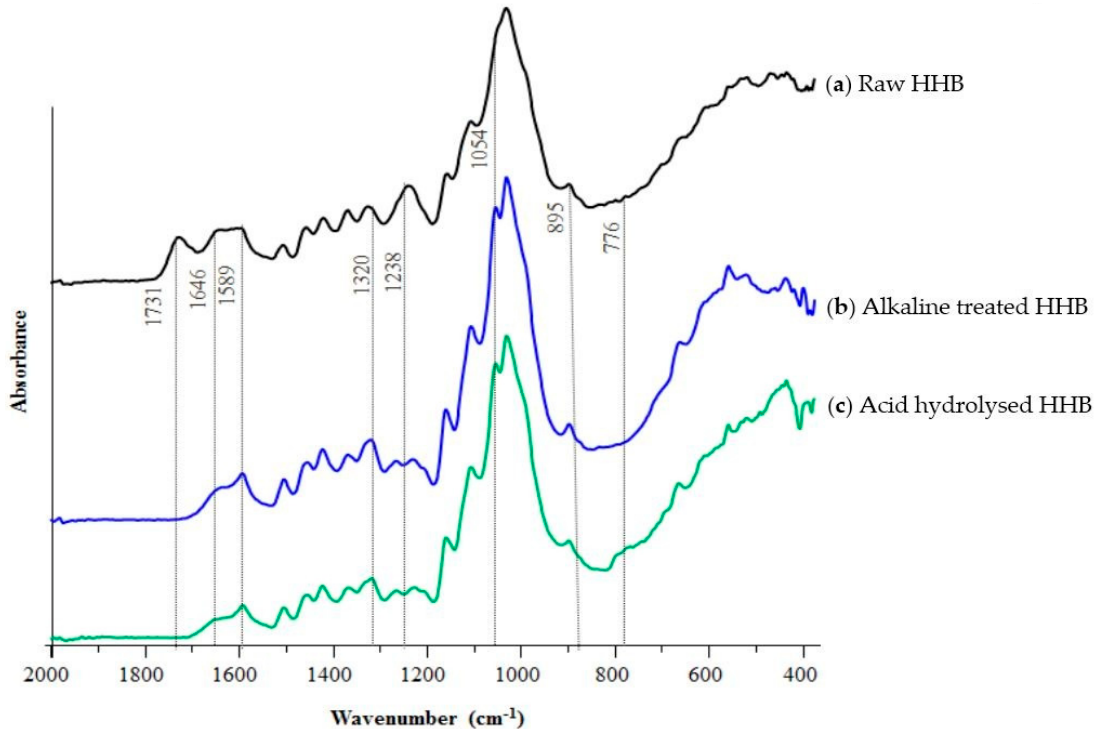
Figure 2. FTIR spectra of HHB at different stages ( a ) raw HHB (black); ( b ) ATH (blue); and ( c ) AHH (green).